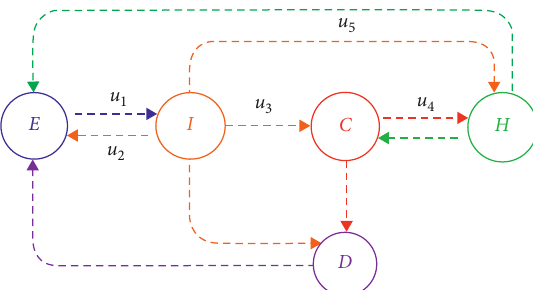
Figure 2: COVID-19 model with control